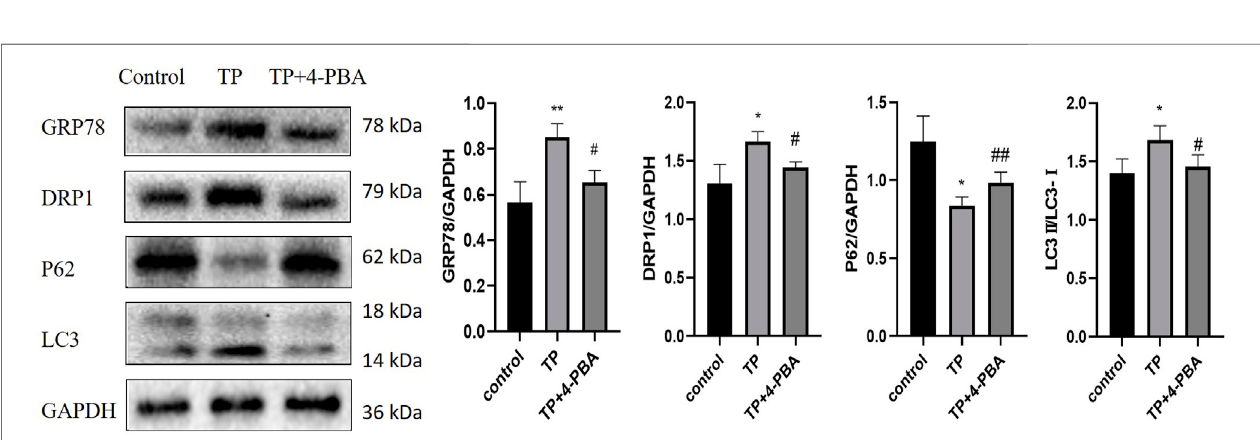
FIGURE6| InhibitionofERSattenuatedTP-inducedexcessivemitophagyinHepaRGcells.TheeffectontheexpressionlevelsofDRP1,P62,andLC3byinhibiting ERS by 4-PBA. Compared with the control group, *p < 0.05, ***p < 0.001 ; compared with the TP group, # p < 0.05, ## p < 0.01.